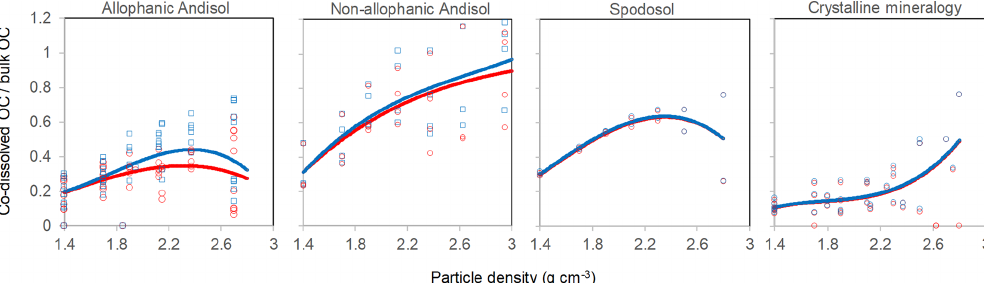
Figure 4. Proportions of bulk C in each density fraction co-dissolved by initial pyrophosphate extraction alone (red circle) and combined with subsequent acid oxalate extraction (blue rectangle), with polynomial fitting curves, for each soil